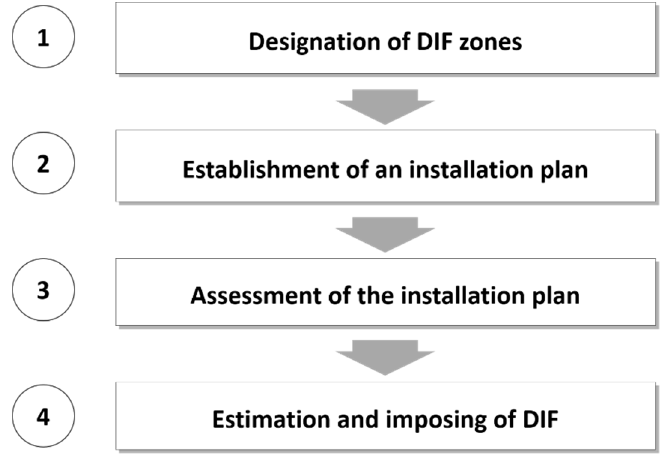
Figure 1. The four stages of infrastructure installation planning in South Korea.